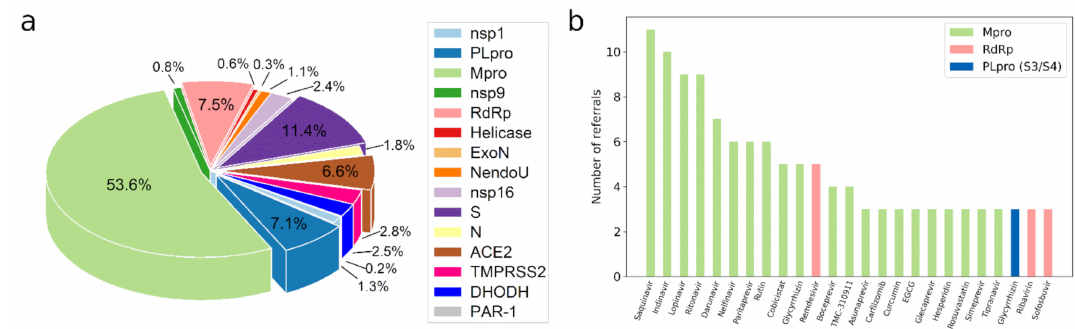
Figure 1. The statistics of compound records retrieved from CADD studies. ( a ) The distribution of compound record numbers classified by drug targets. ( b ) The CADD recommended compounds reported in more than two publications. Their targets included Mpro, RdRp, and PLpro. S3 and S4 are the two binding sites of PLpro.